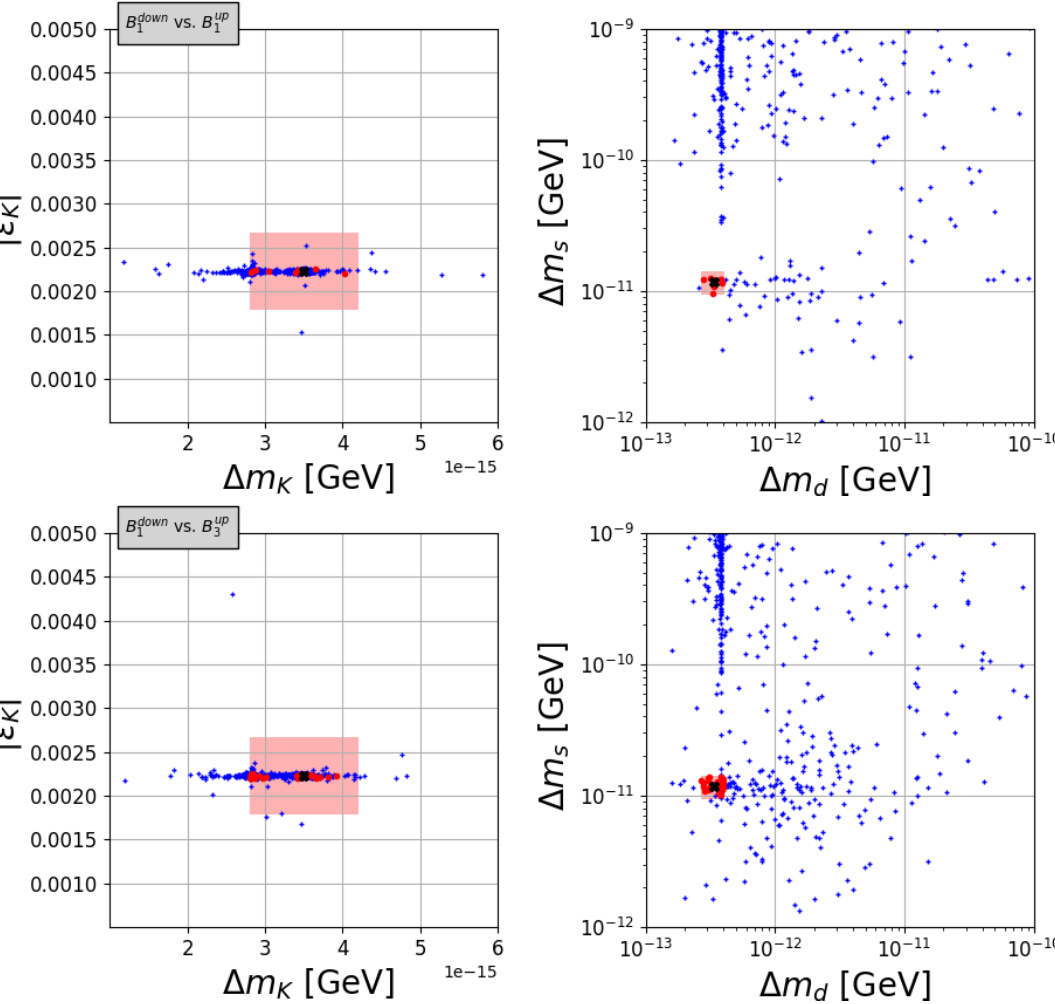
Figure 5 . Meson sector predictions for ( B 1 ; B 1 ) (upper) and ( B 1 ; B 3 ) (lower) scenarios. The red dots indicate the points, which satisfy the K - and B -meson oscillations parameters within the chosen margins shown by pink